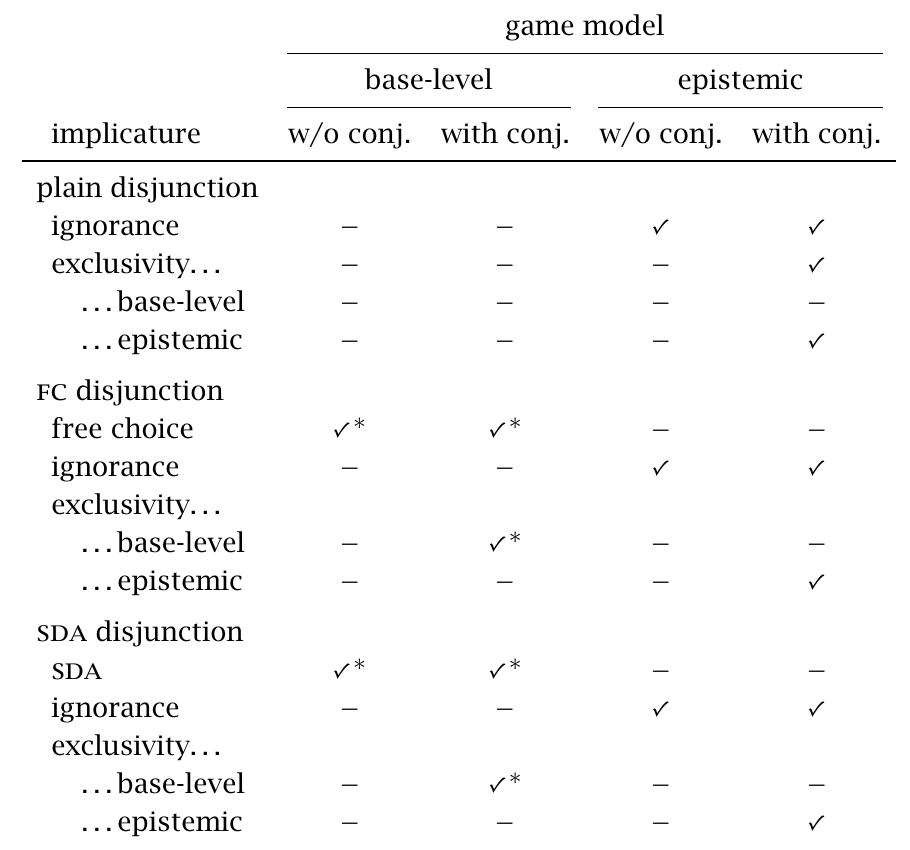
Figure 15 Results of the ibr model for the implicatures listed in Figure 2 . Checkmarks indicate that an implicature can be derived in a context model type. Asterisks indicate that extra assumptions are necessary for cases with more than two